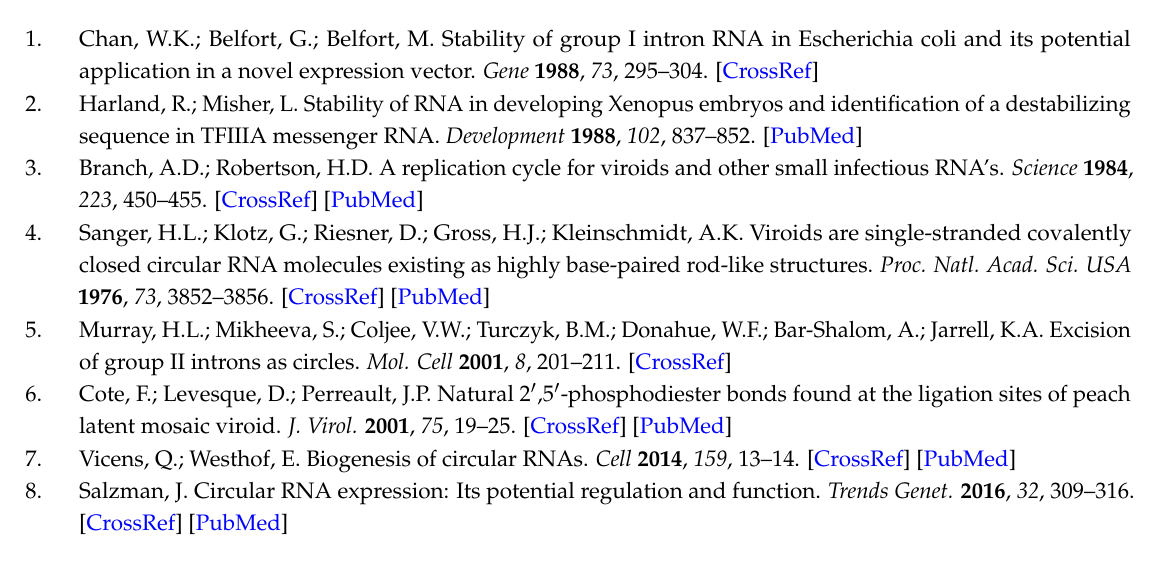
Figure S1: The full length intron circle (FLC) is predominantly confined to the nucleus in exponential growing D. iridis cells. Figure S2: Chemical and RNase probing of the linear (L-IVS) and circular (FLC) DiGIR2 intron. Figure S3: Sequence covariation between the P5 receptor and L9 sequence. Figure S4: The FLC and L-IVS DiGIR2 ribozyme 3D model overlay. Table S1: Intron processing pathways. Table S2: Results from Pb2+ and in-line probing of nucleotide 200-318 of DiGIR2 FLC and